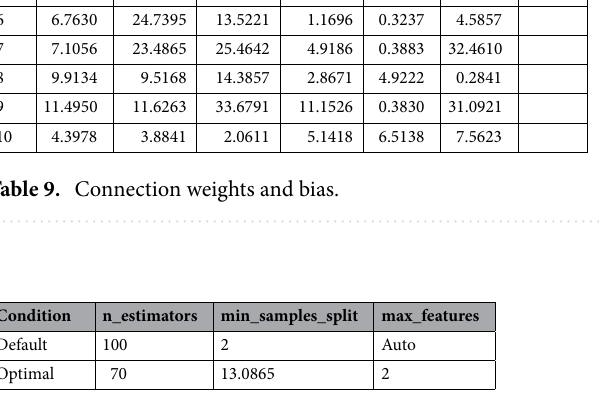
Table 10. Hyperparameter optimization.